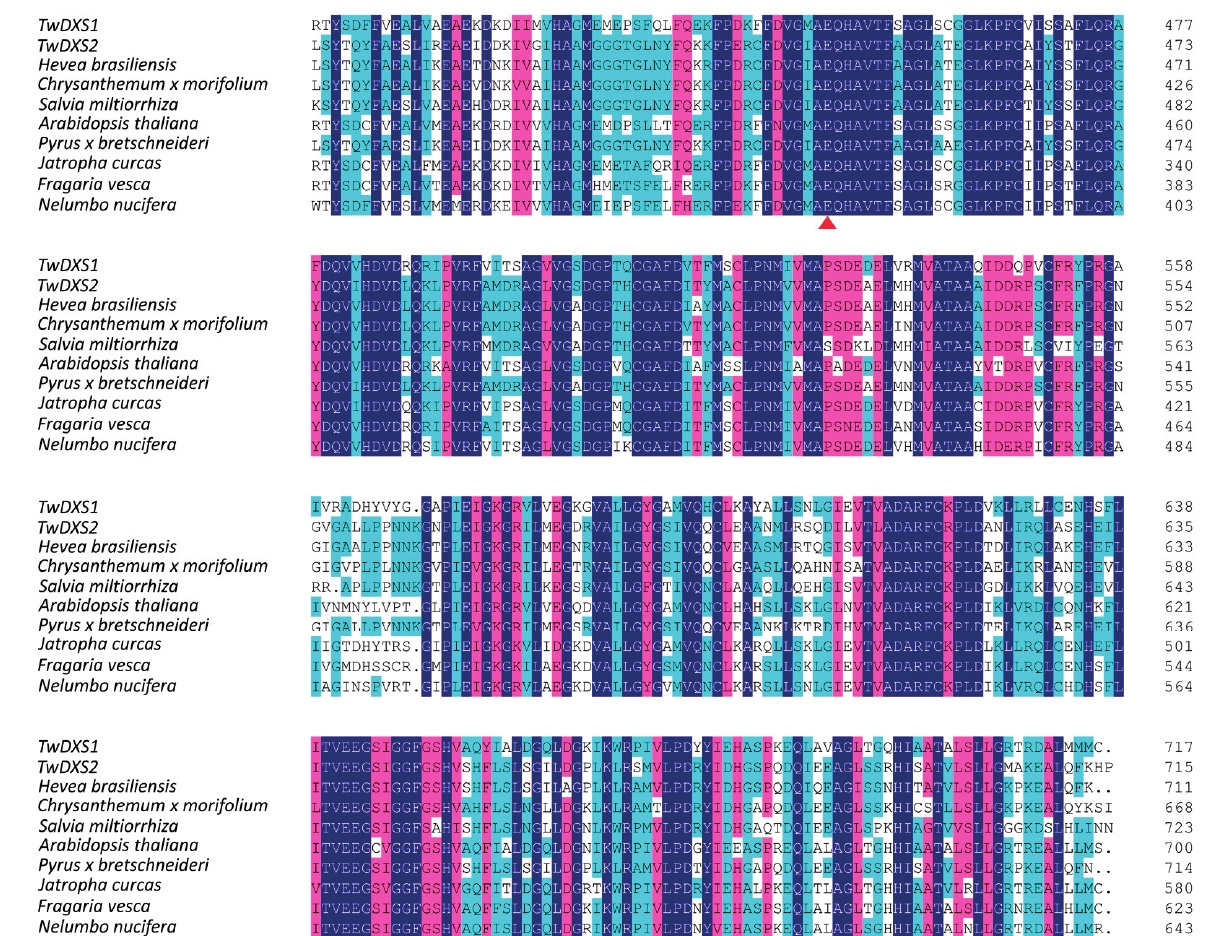
Figure 1. Multiple alignments of TwDXS1 and TwDXS2 with other plant DXSs. A multiple alignment of T. wilfordii DXS with the DXS of other plants was analyzed on DNAMAN 8.0 and based on the following protein-sequence data: Hevea brasiliensis (BAF98289.1),